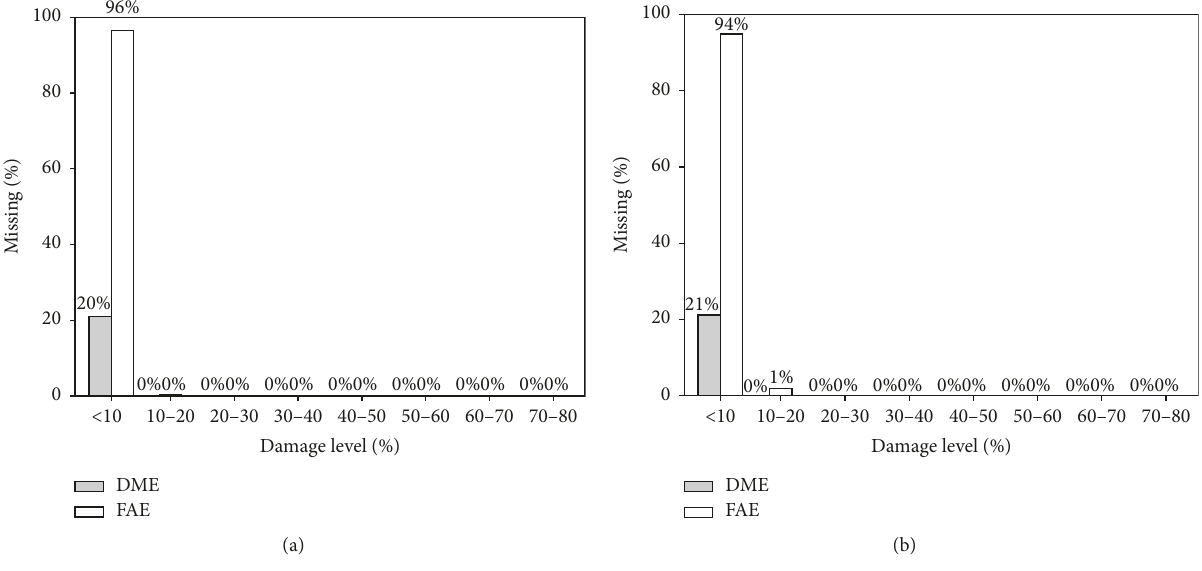
Figure 11: DME and FAE for model 2 (a) and model 3 (b), spring series case study.